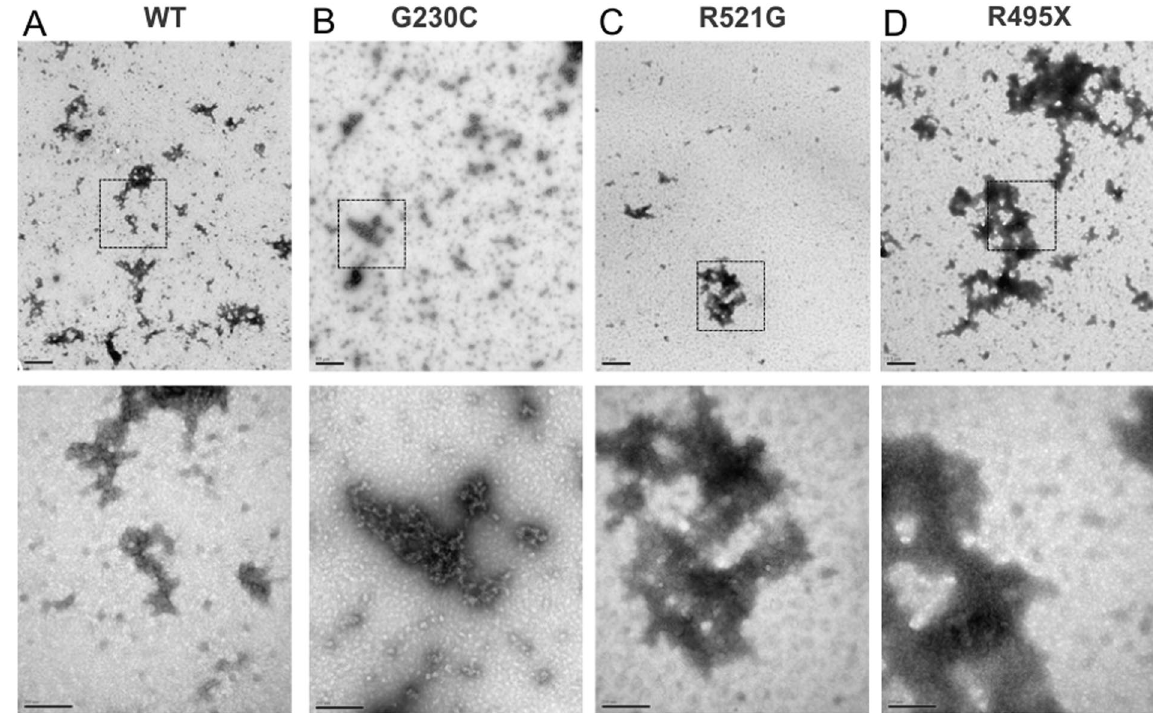
Figure 3. The morphology of FUS species assessed by electron microscopy. Representative electron microscopy (EM) images of negatively stained FUS WT ( A ), G230C ( B ), R521G ( C ) and R495X ( D ) proteins. Low magnification images are shown in the top row (scale bar represents 0.5 μ m). High magnification images are shown for insets (dashed squares) in the bottom row (scale bar represents 200 nm). FUS exhibits heterogeneous morphologies across all